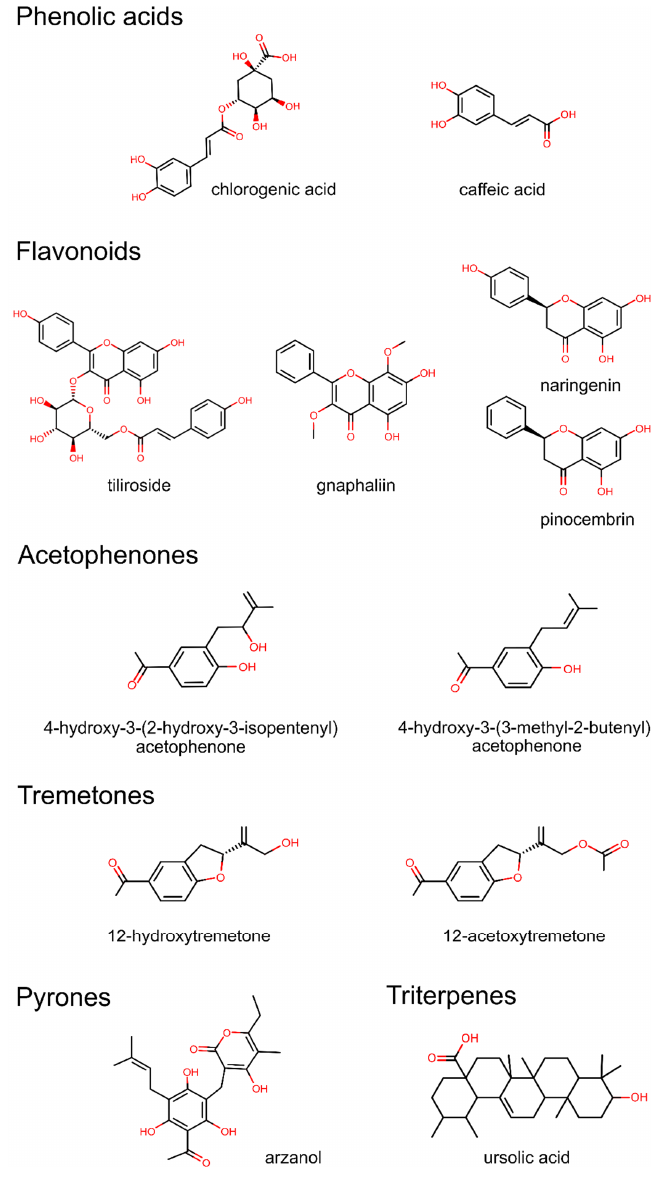
Figure 3. Major bioactive compounds from Helichrysum italicum extracts.